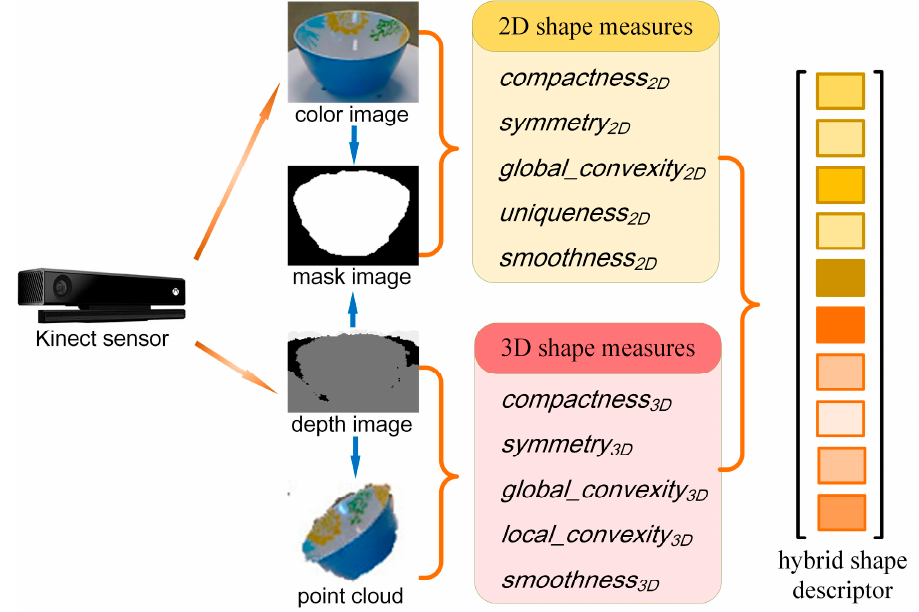
Figure 1. The flowchart of the proposed approach.